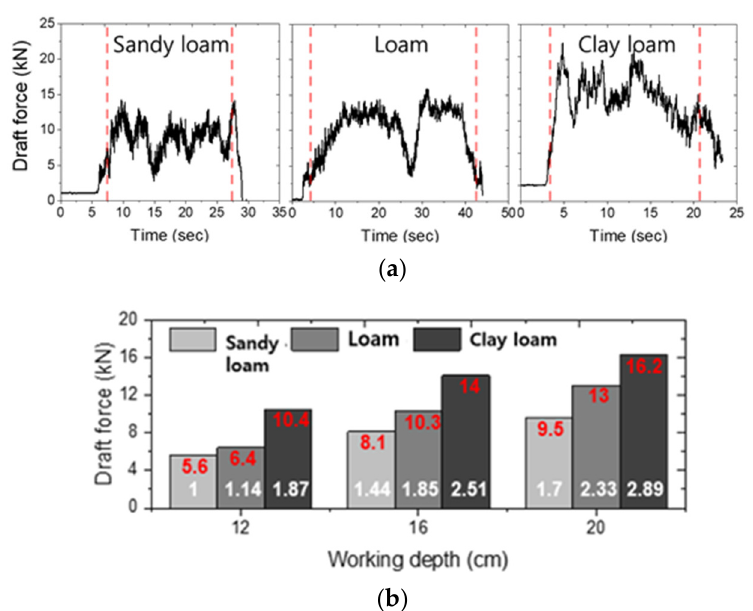
Figure 6. ( a ) Field measurements results of draft force under various field sites; ( b ) Comparison analysis of draft force by tillage depth and test sites.